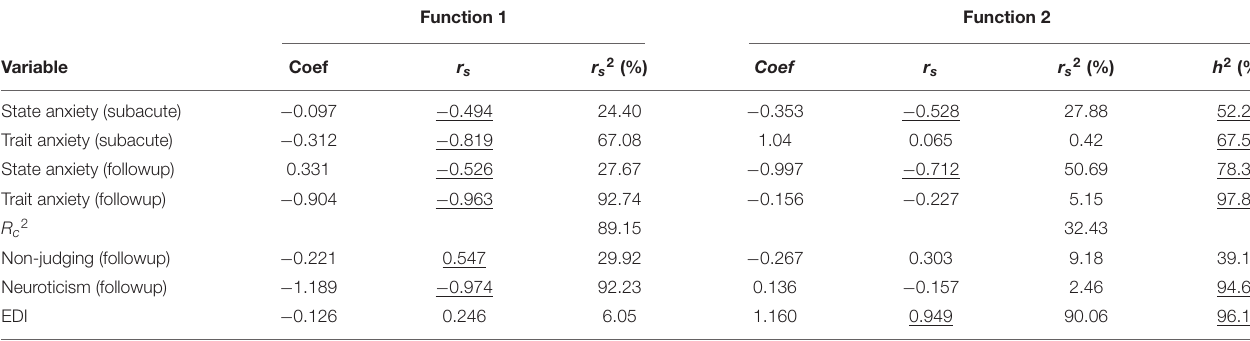
TABLE 3 | Canonical solution for psychological variables predicting state and trait anxiety for Functions 1 and 2. Function 1 Function 2